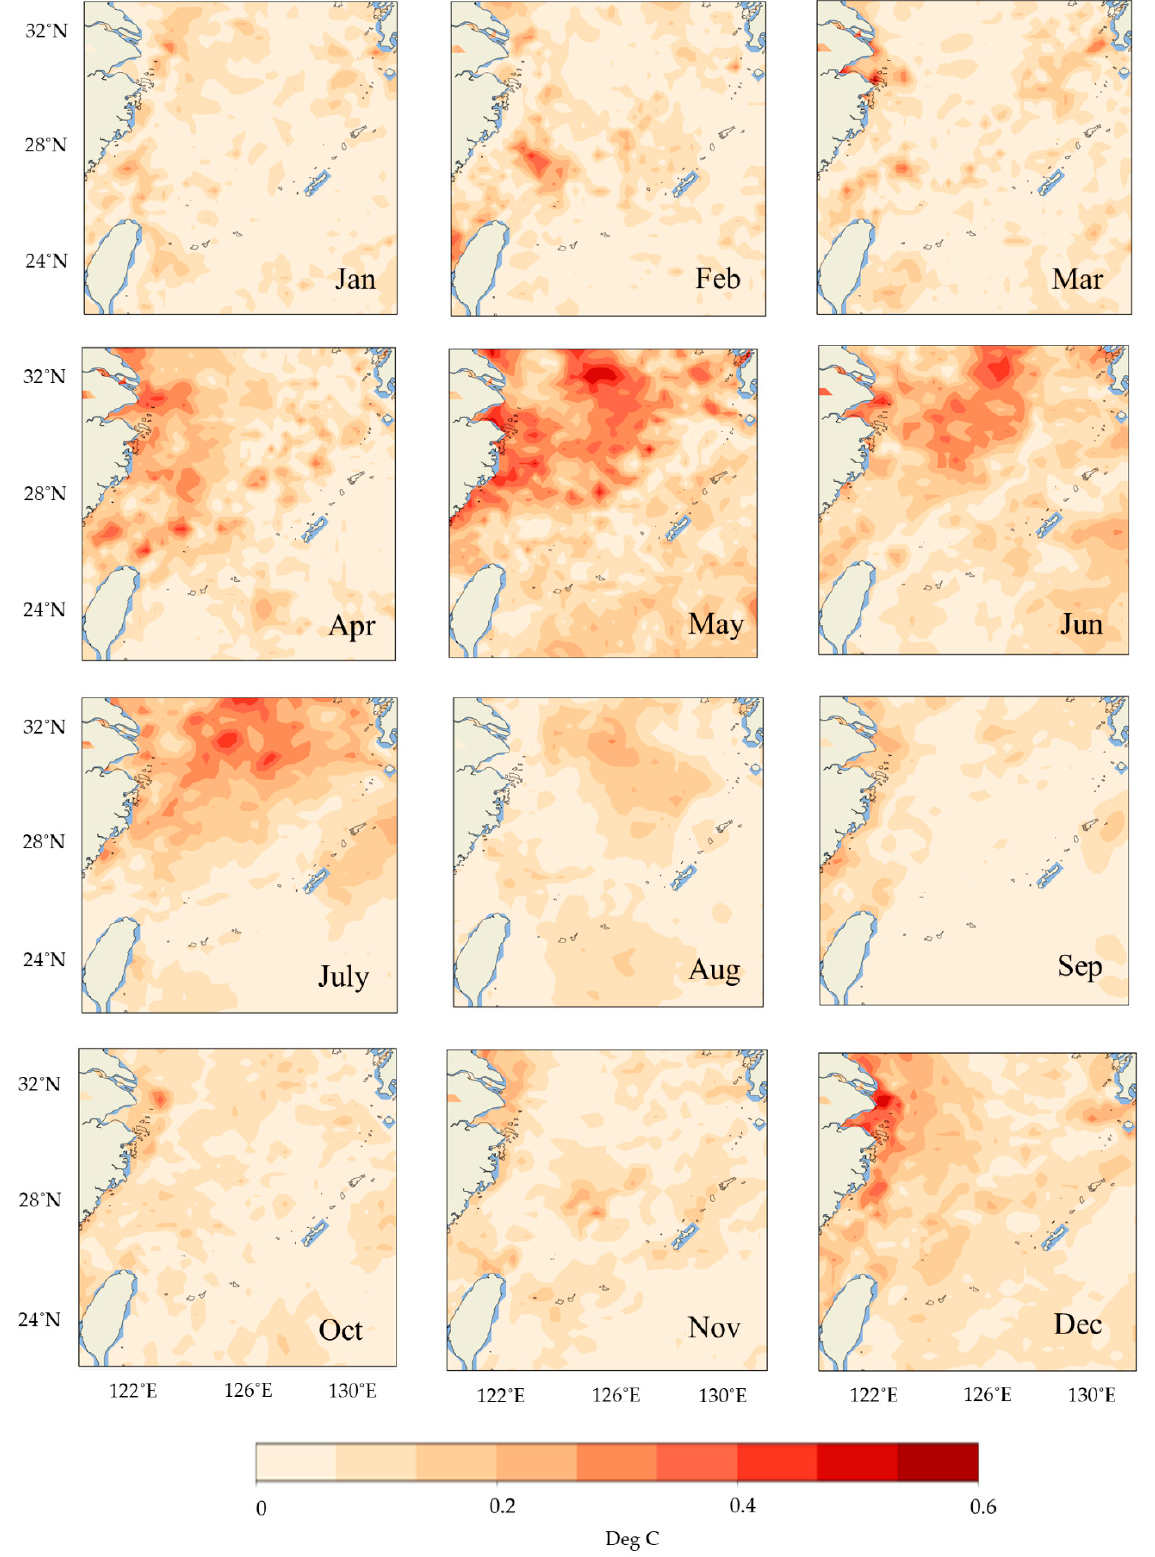
Figure 8. Spatial distribution of monthly mean AE of OSTIA data and LSTM predictions of sea surface temperature in 2020. The unit of colorbar is degrees Celsius.